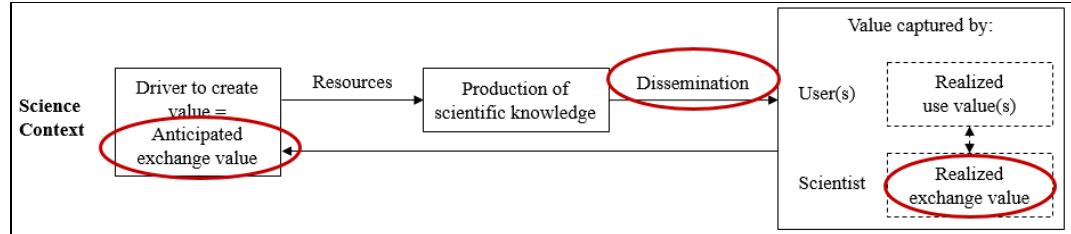
Figure 2. Theoretical conceptualization including the foci of this exploratory study. Source: own illustration adapted from Bowman and Ambrosini [2].